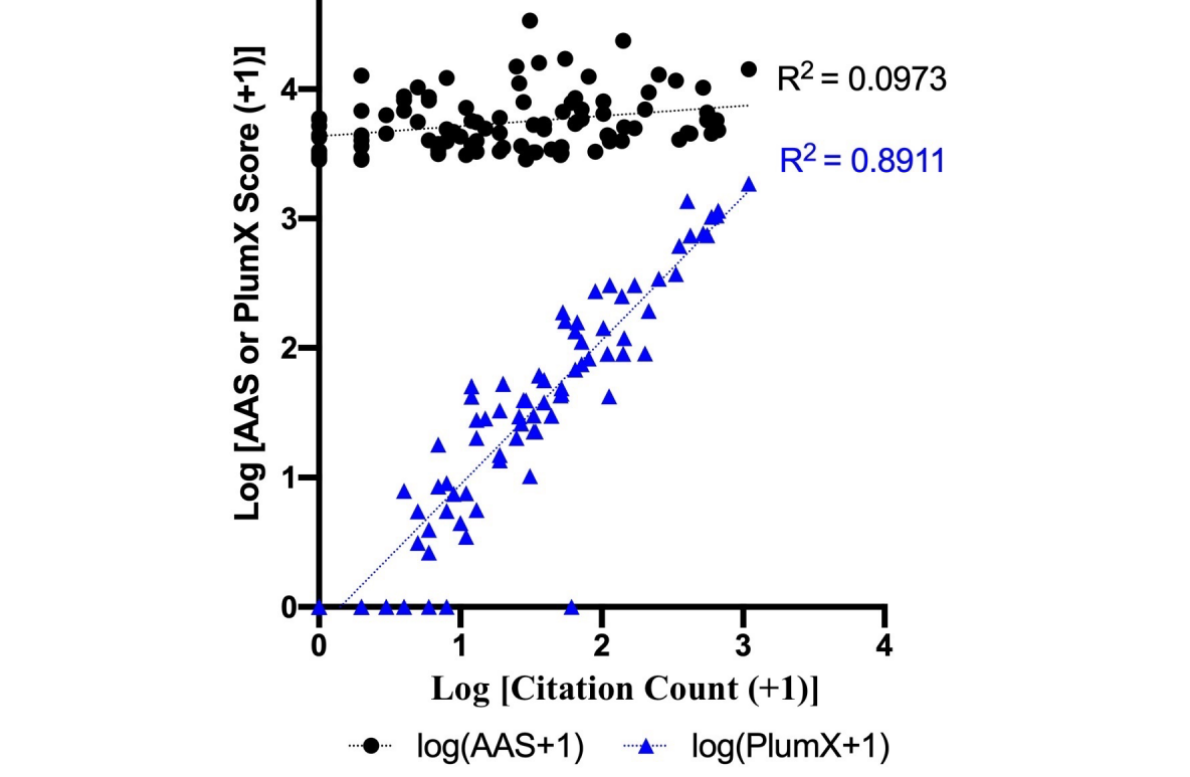
Figure 1. Correlations between citation count and AAS and between citation count and PlumX score. AAS: Altmetric Attention